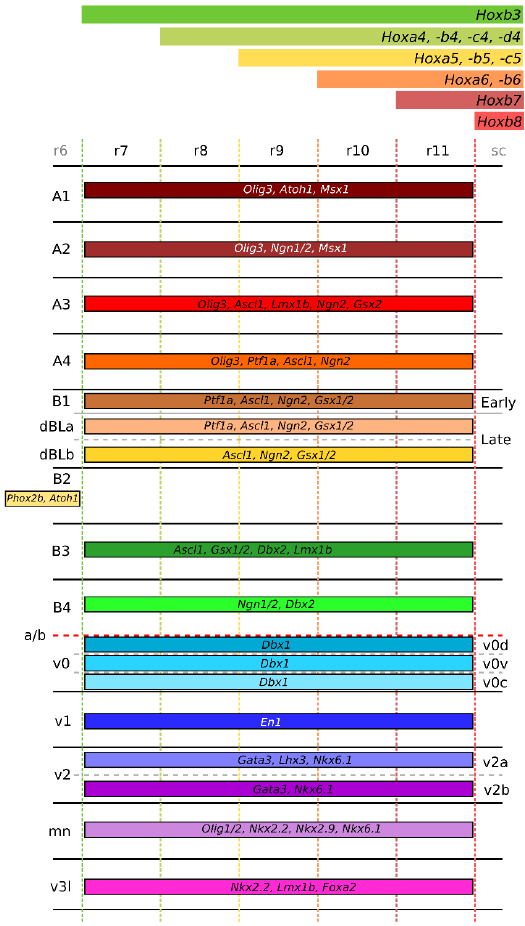
Figure 2. Location and gene expression of progenitor domains in the developing medulla oblongata. Overview of the location and gene expression of progenitors present in the developing